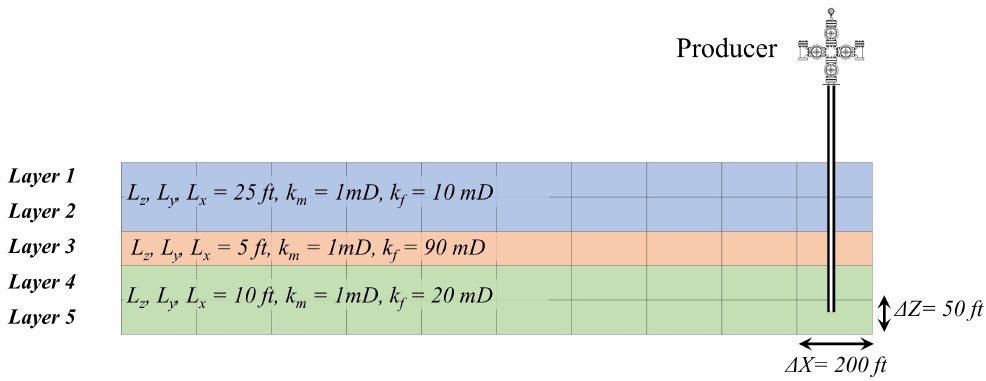
Figure 2. Cross-sectional model of the 6th SPE comparative solution project which illustrates the model layers with their